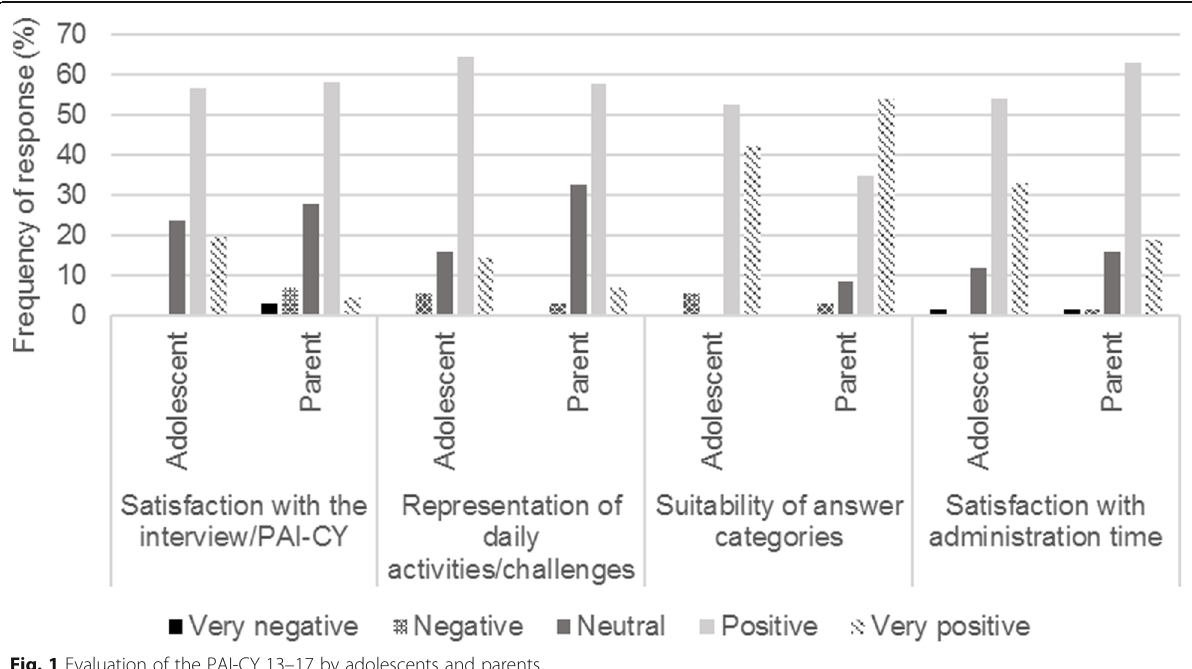
Fig. 1 Evaluation of the PAI-CY 13 – 17 by adolescents and parents